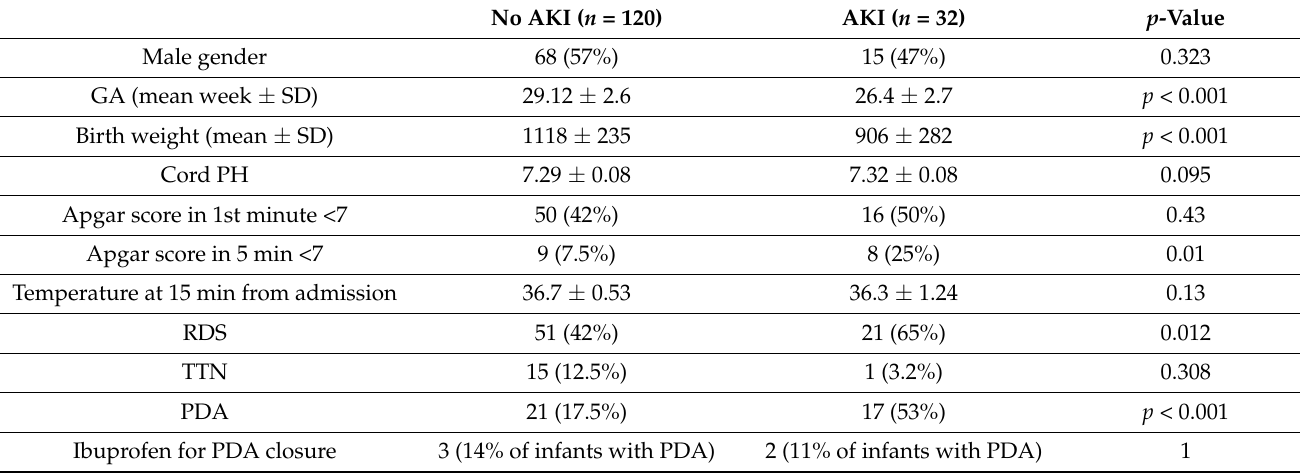
Table 1. Patient information among VLBW infants with and without AKI, comorbidities, interventions. No AKI ( n = 120) AKI ( n =